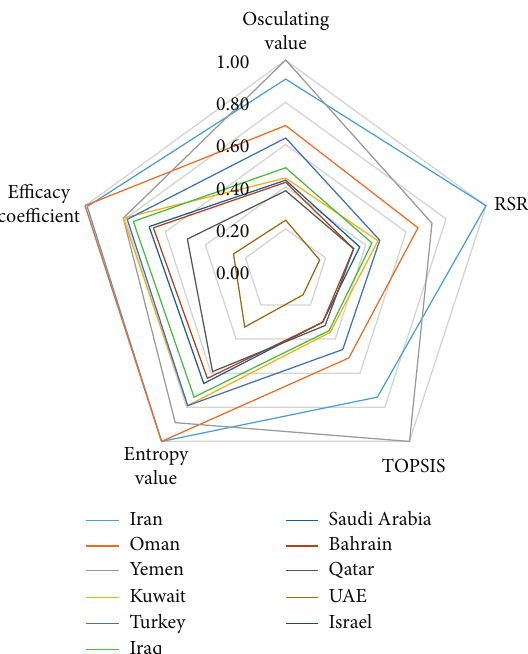
Figure 11: Matching effect picture of Chinese power companies in the Middle East.